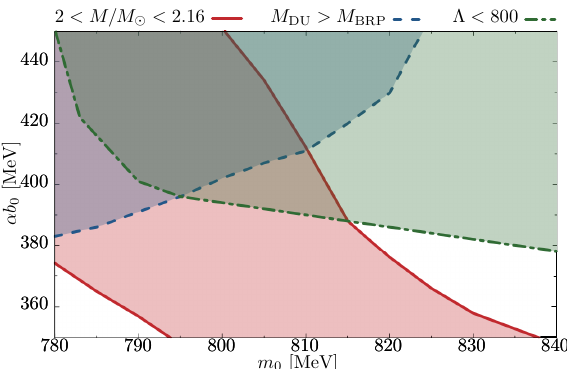
Figure 6. Constraints on the model parameters m 0 and α b 0 .